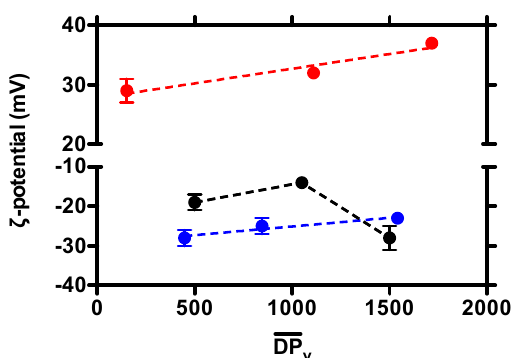
Figure2. Dependenceofcoacervatesurfacecharge( ζ -potential)onthechitosandegreeofpolymerization ( DP v ) for formulations at di ff erent fractions of acetylated units, F A : F A = 0.16 (red dots), F A = 0.46 (black dots) and F A = 0.63 (blue dots). Dashed lines are drawn to guide the eye. A negative surface charge was, at variance, detected for coacervates composed of F A = 0.46 and